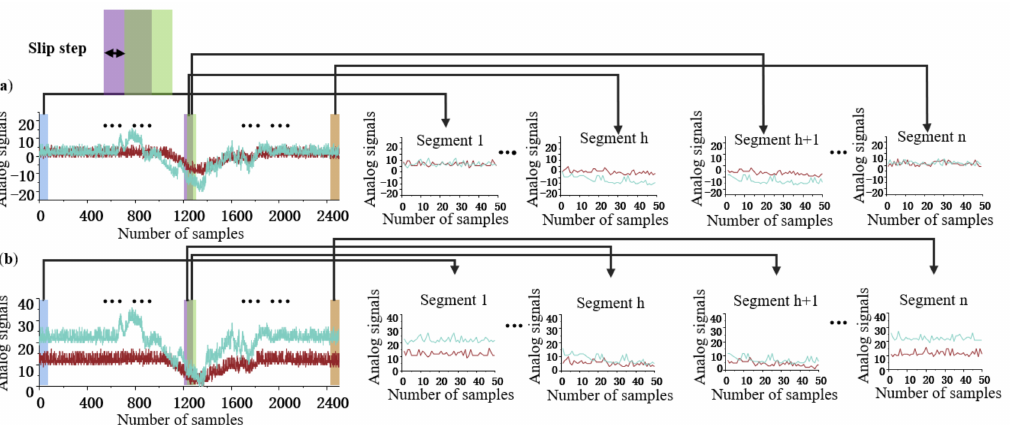
Figure 3. Schematic diagram of tactile data segmentation. ( a ) Schematic diagram of tactile signal segmentation with DC component filtering; ( b ) schematic diagram of tactile signals segmentation with minimum value